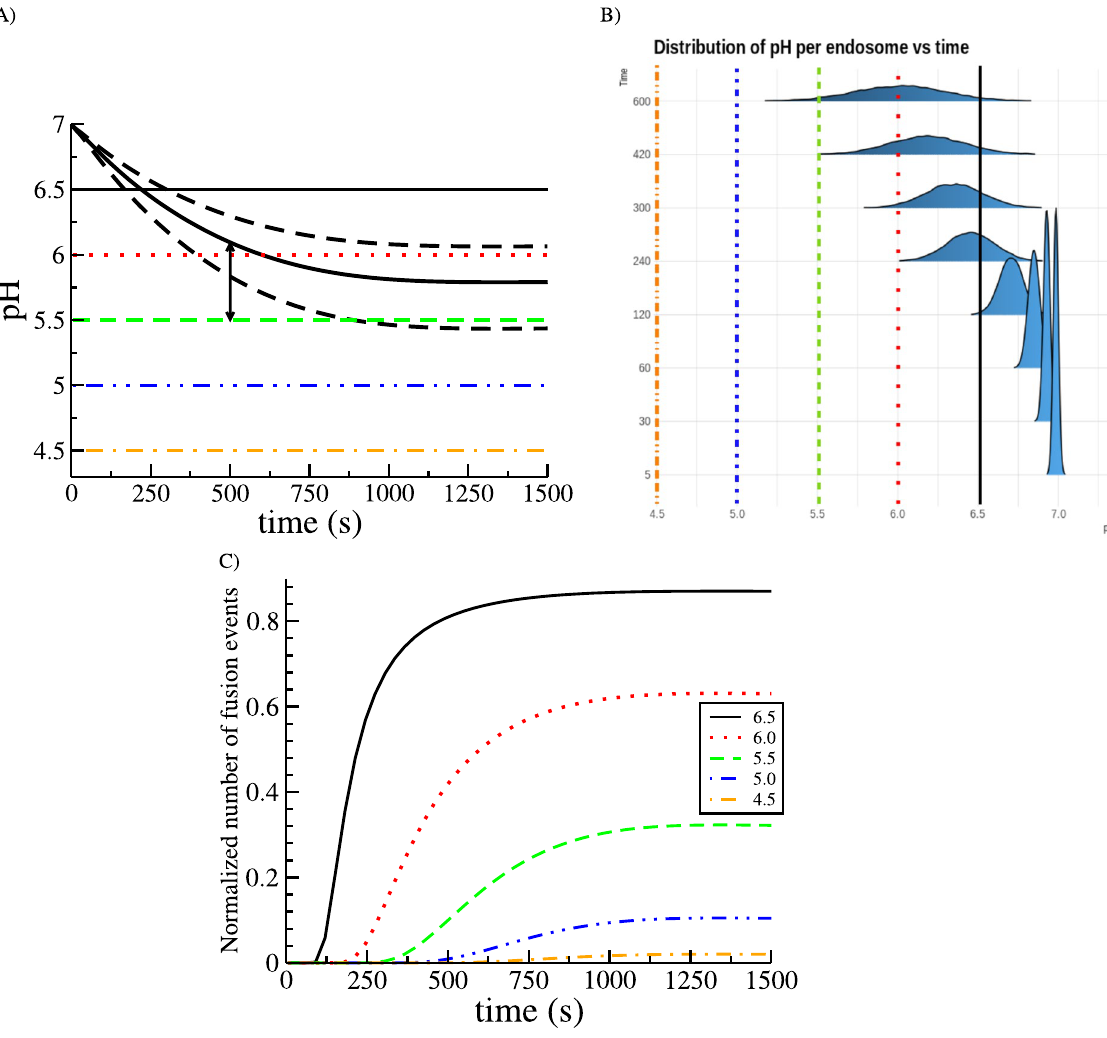
Figure 5. Cut-off switch model predicts large endosomal pH fluctuations. ( A ) Time evolution of the mean endosomal pH (thick curved line) computed from Eqs. (17)–(19) and Eq. (1), and mean ± standard deviation (computed from Eqs. (S26)–(S28) in Supplementary Information, curved dashed lines). The horizontal colour lines correspond to different pH thresholds that could regulate and trigger virus endosomal escape. ( B ) Similar to ( A ) but showing the sampled distribution of pH using Eq. (26). Note how the distribution broadens with time, thus increasing the probability of crossing a given pH threshold. ( C ) Normalised number of viral escape events quantified as the probability of pH being below a threshold (see colour-coded legend), making use of Eq. (26), namely, P [ N ( pH, σ pH ) < threshold ]